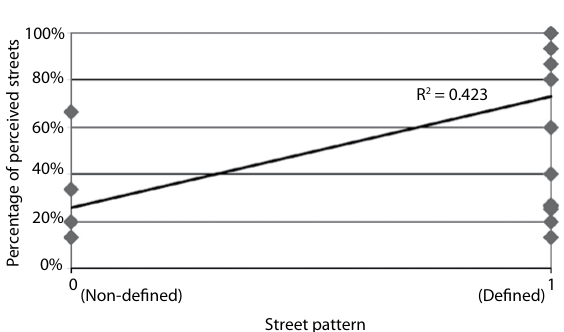
fig. 9. Comparison chart between street patterns and percentage of perceived streets in Kenmore and Kendall Sq.